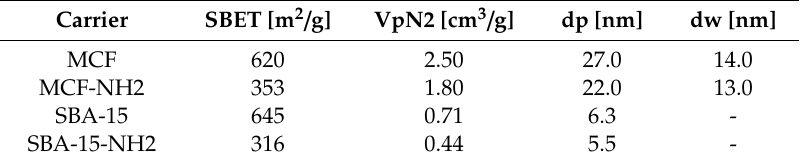
Table 2. Characterization of the silica carriers used in immobilization. Carrier SBET [m 2 / g] VpN2 [cm 3 / g] dp [nm] dw [nm] MCF 620